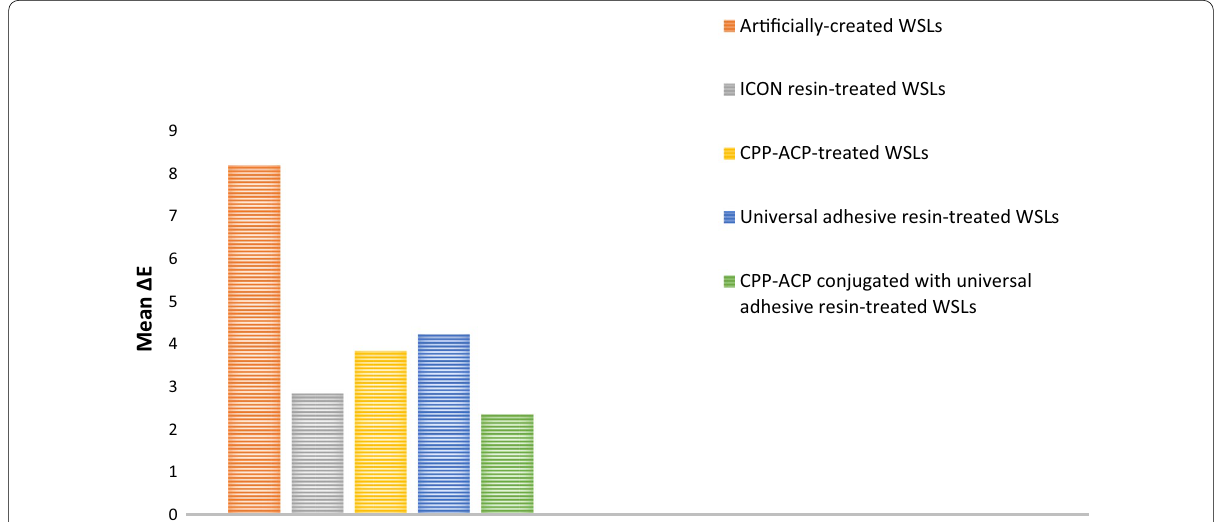
Fig. 2 Color difference results of the investigated groups